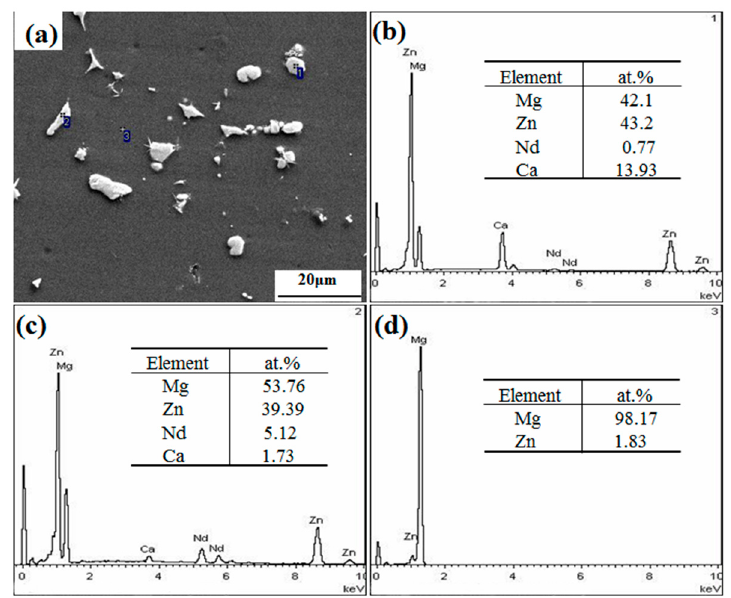
Figure 3. SEM image and EDS spectra of the extruded Mg-6Zn-0.5Nd-0.5Ca alloy. ( a ) SEM image of extruded Mg-6Zn-0.5Nd-0.5Ca alloy; ( b ) EDS spectra and element content of Point 1; ( c ) EDS spectra and element content of Point 2; ( d ) EDS spectra and element content of Point 3.